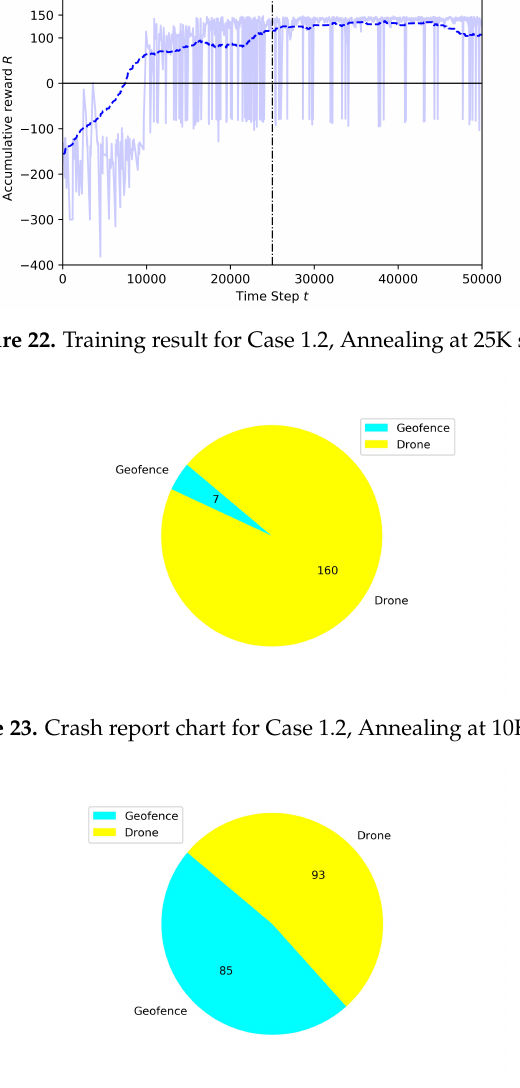
Figure 24. Crash report chart for Case 1.2, Annealing at 25K